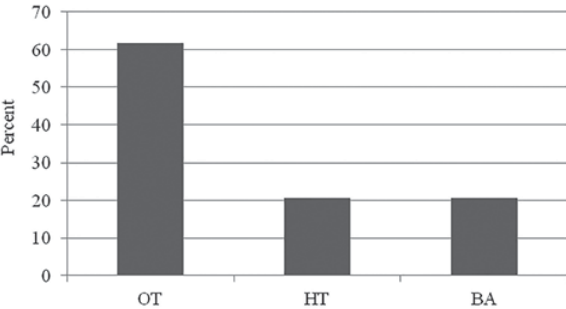
Figure 1- Prevalence of halitosis positive diagnosis performed by the Organoleptic Test (OT), Halimeter™ (HT) and Breath